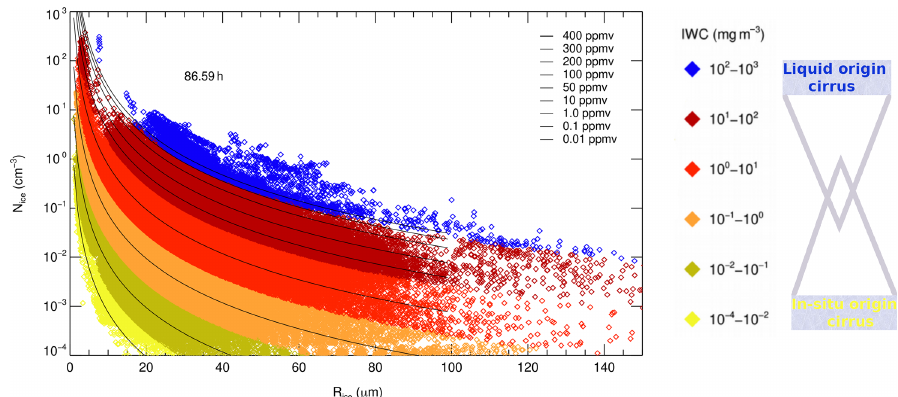
Figure 4. Relation between ice crystal concentration N ice and mean mass radius R ice , color coded by the ice water content IWC in milligrams per cubic meter, from ∼ 87h of cirrus cloud observations ( R ice is calculated by dividing IWC by N ice ). The thin black lines are isolines of IWC as volume mixing ratio (in the order of the legend). The scheme at the right side illustrates the partitioning of the clouds between “liquid origin” and “in situ origin”: the thickest cirrus (blue points) are of liquid origin; the thinnest (yellow points) of in situ origin. As the thickness decreases, the portion of liquid-origin cirrus becomes smaller and smaller while more and more in situ-origin cirrus